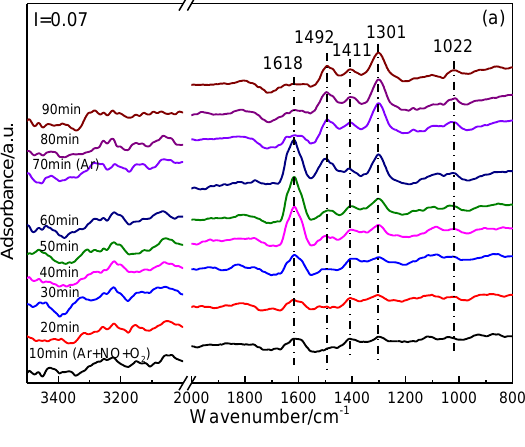
Figure 6. DRIFT spectra of SSOC in the condition of 1000 ppm NO and 15% O 2 at 250–350 ◦ C for 30 min.